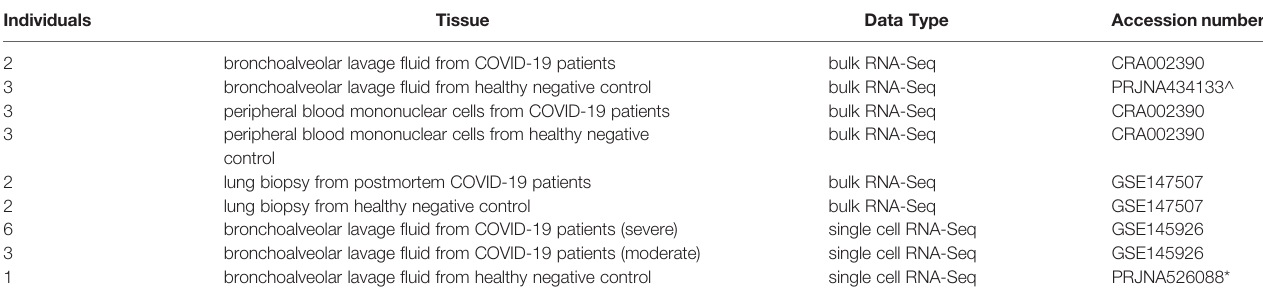
TABLE 2 | Data of COVID-19 patients included in this